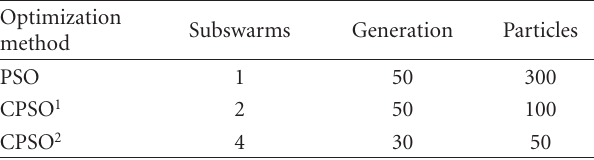
Figure 5: The particle scheme of cooperative PSO with more subswarms. Table 3: The values of the parameters used in the experiments; CPSO 1 : swarms located in the feature space. CPSO 2 : swarms located in the instance (data)